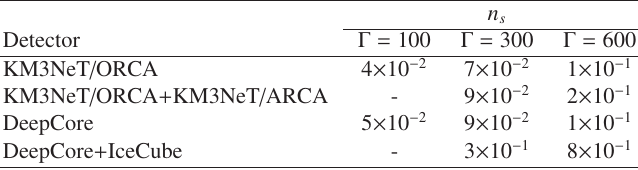
Table 1: Number of events from ν µ + ¯ ν µ interactions expected from a GRB with γ -ray fluence F γ 2 10 − 3 erg cm − 2 in low-energy detectors (KM3NeT / ORCA and DeepCore) alone, or in a combined × search with high-energy detectors (KM3NeT / ARCA and IceCube, respectively). All of these results are given at trigger level.